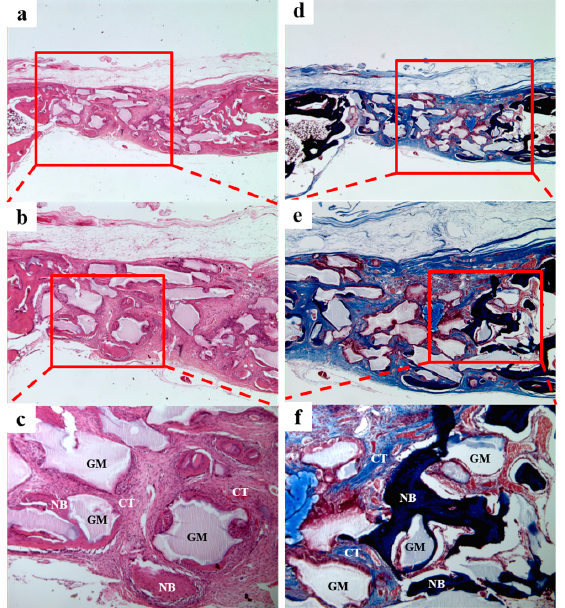
Figure 11. Histological sections of the BCP/CMC group at 4 weeks after surgery. A small amount of new bone formation and a substantial amount of fibrous connective tissue were observed. NB, new bone; GM, grafted material; CT, connective tissue. H&E stain results ( a – c ); and Masson’s trichrome stain results ( d – f ) (original magnifications: ×20 ( a , d ); ×40 ( b , e ); and ×100 ( c , f )).